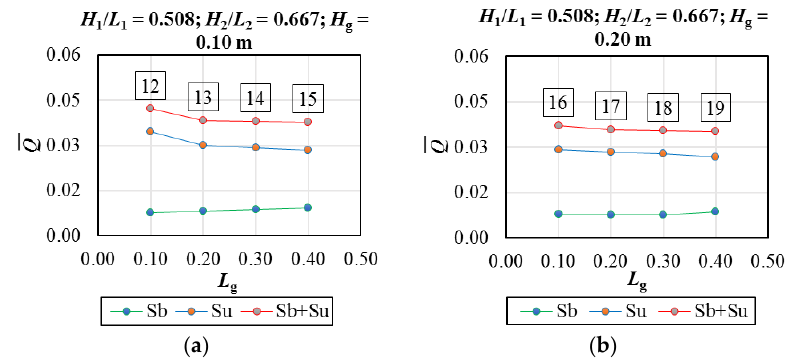
Figure 19. Behavior of Q ̅ × L g for: ( a ) cases 12, 13, 14 and 15 and ( b ) 16, 17, 18 and 19.